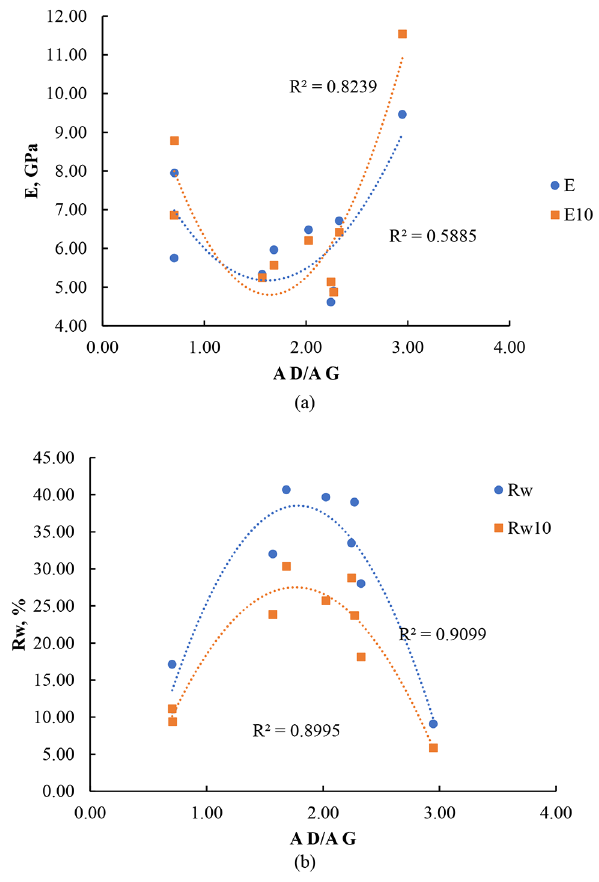
Fig. 8 Correlations between coals mechanical properties for a Elastic moduli b Damage index, and some structural parameters measured by Raman spectroscopy